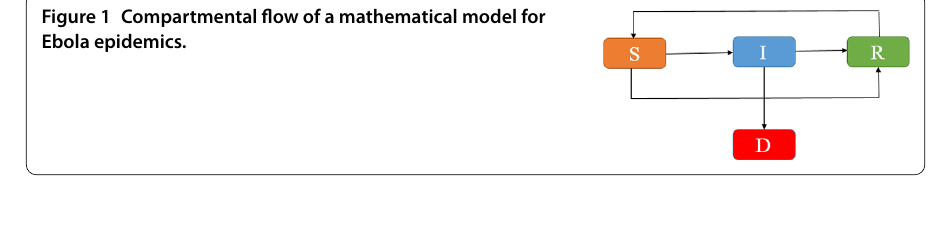
parameters are defined in Section